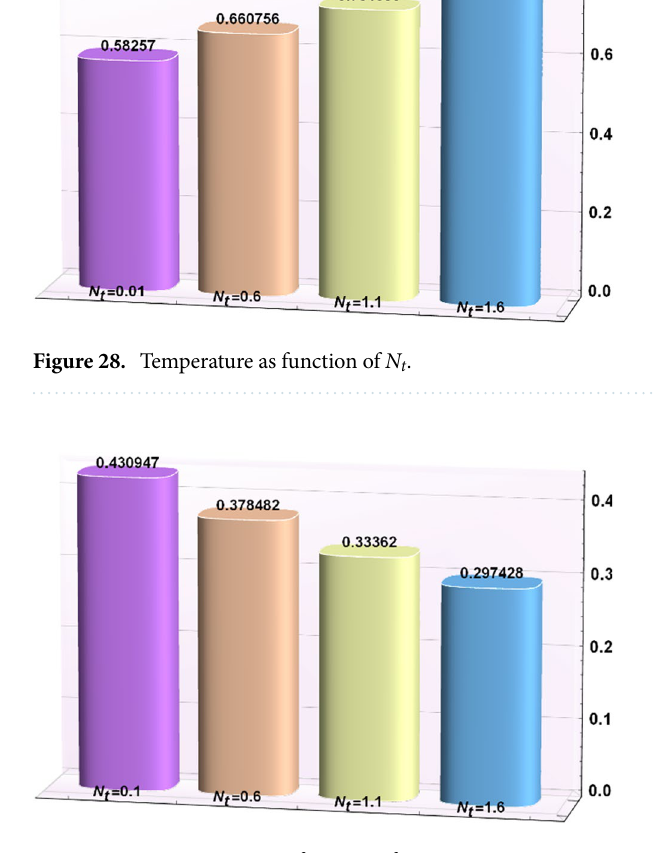
Figure 29. Concentration as function of N t